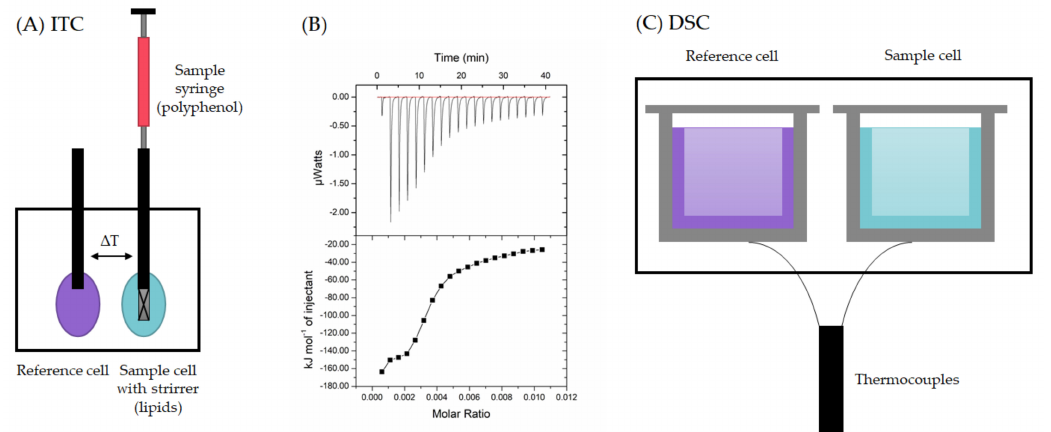
Figure 3. ( A ) Isothermal titration calorimeter (ITC), ( B ) raw ITC data (upper panel) and the thermo- gram (lower panel) of ellagitannin rugosin G titrated into lipid vesicles of Escherichia coli (control titration of ellagitannin into buffer subtracted), ( C ) differential scanning calorimeter (DSC) with crucible cells for sample and reference